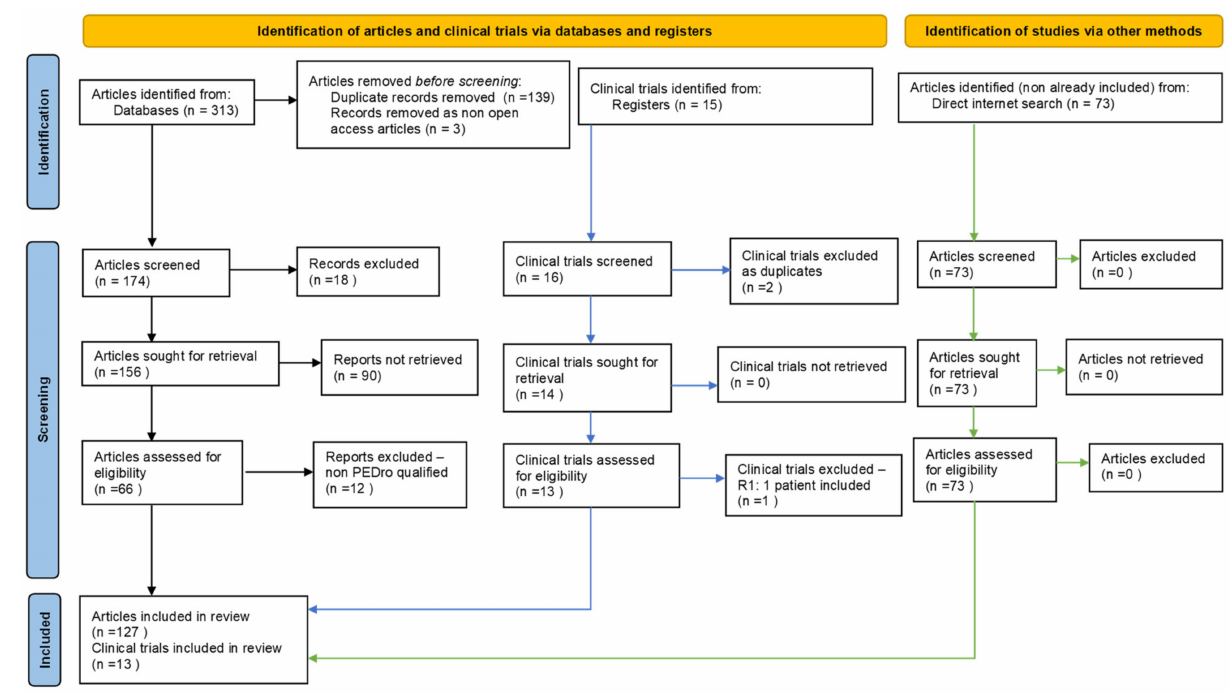
Figure 2. Our adapted PRISMA-type flow diagram